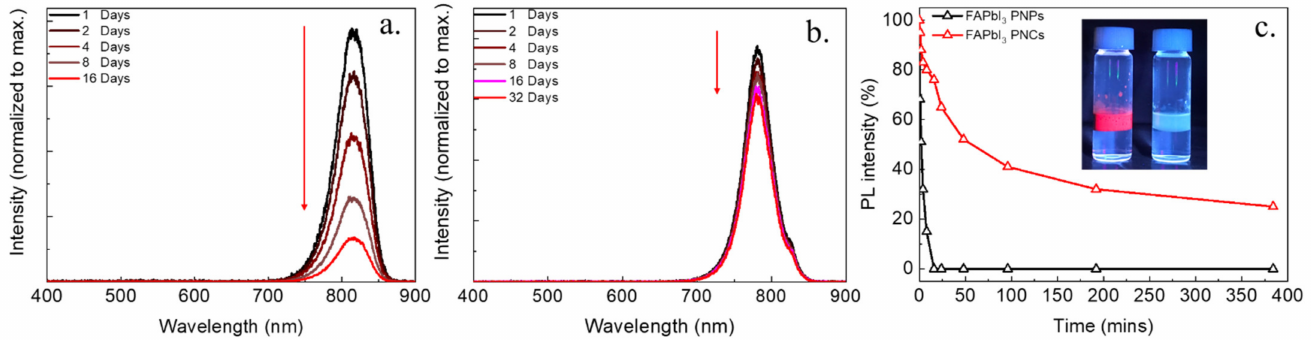
Figure 6. The PL spectra of FAPbI 3 ( a ) PNP and ( b ) PNC powders stored in air after different days; ( c ) the intensity of the PL peaks under the DI water as a function of times for FAPbI 3 NPN and PNC-dispersed solutions. The insets show the photographs of the FAPbI 3 NPNs and PNCs added into water after 16 min.